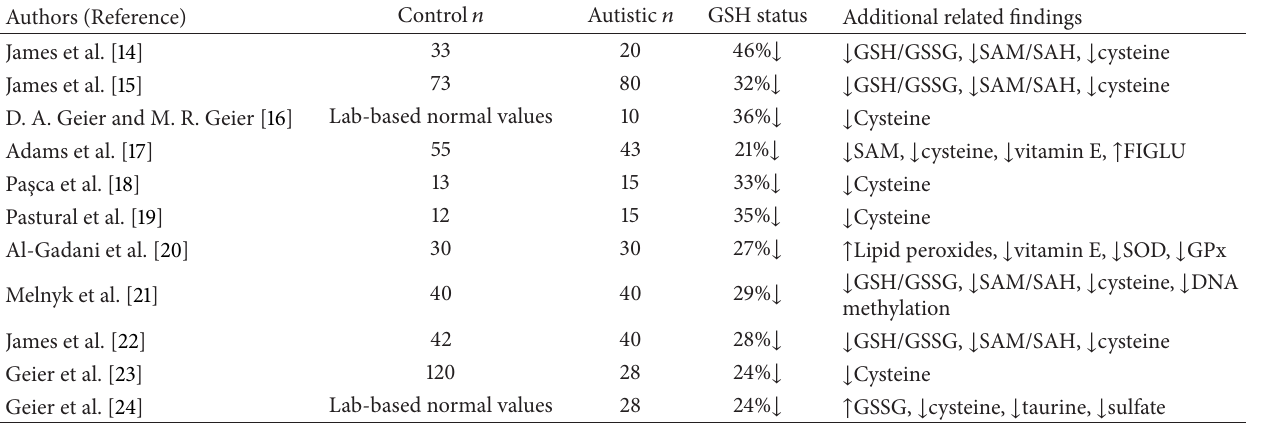
Table 1: Glutathione and oxidative stress in